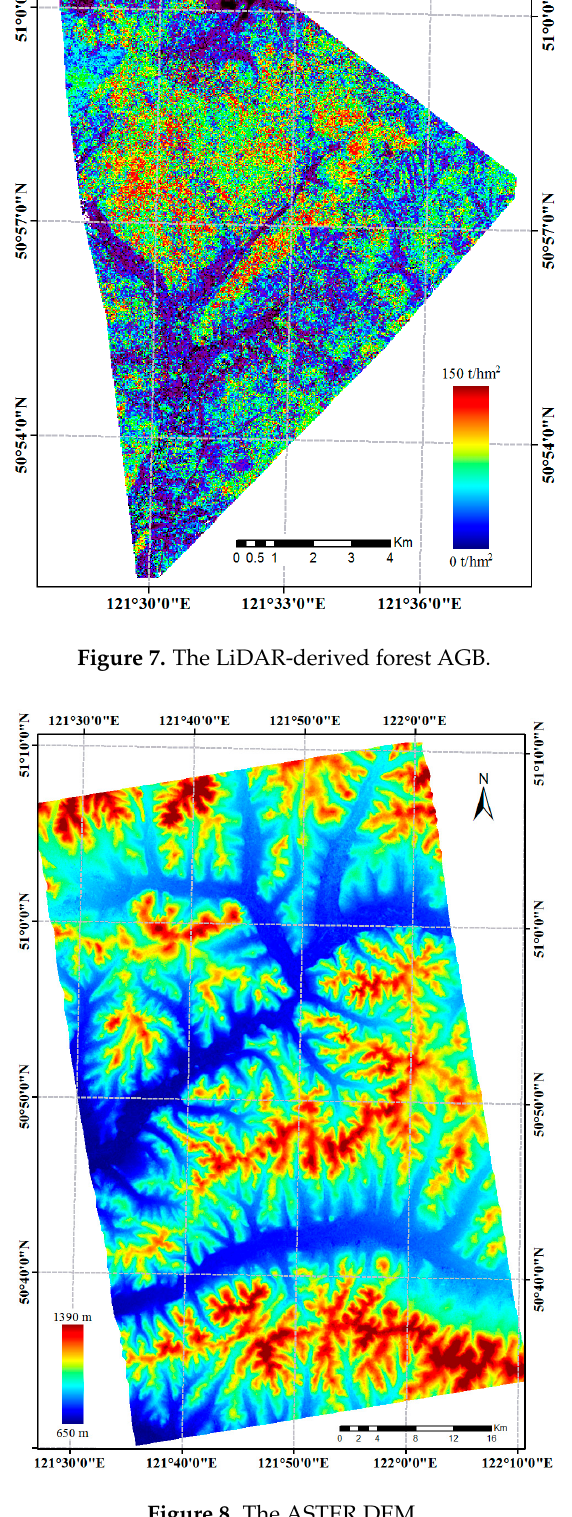
Figure 8. The ASTER DEM.